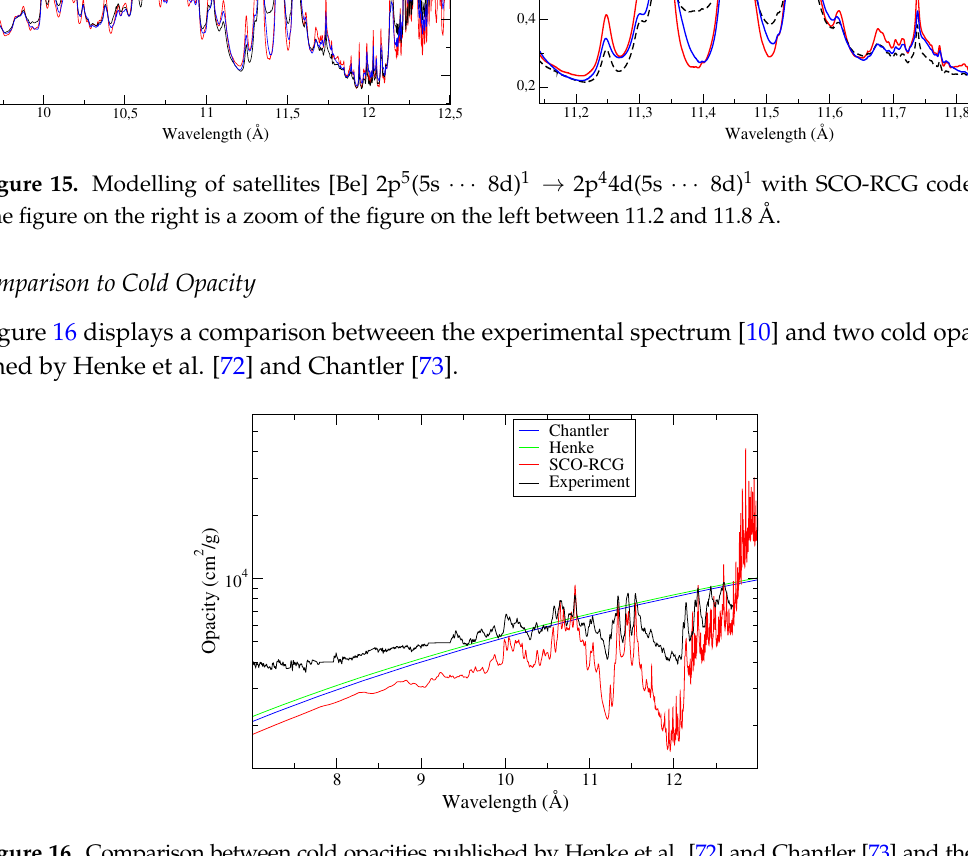
Figure 16. Comparison between cold opacities published by Henke et al. [72] and Chantler [73] and the experimental spectrum [10]. The SCO-RCG opacity at T = 182 eV and n e = 3.1 × 10 22 cm − 3 is also